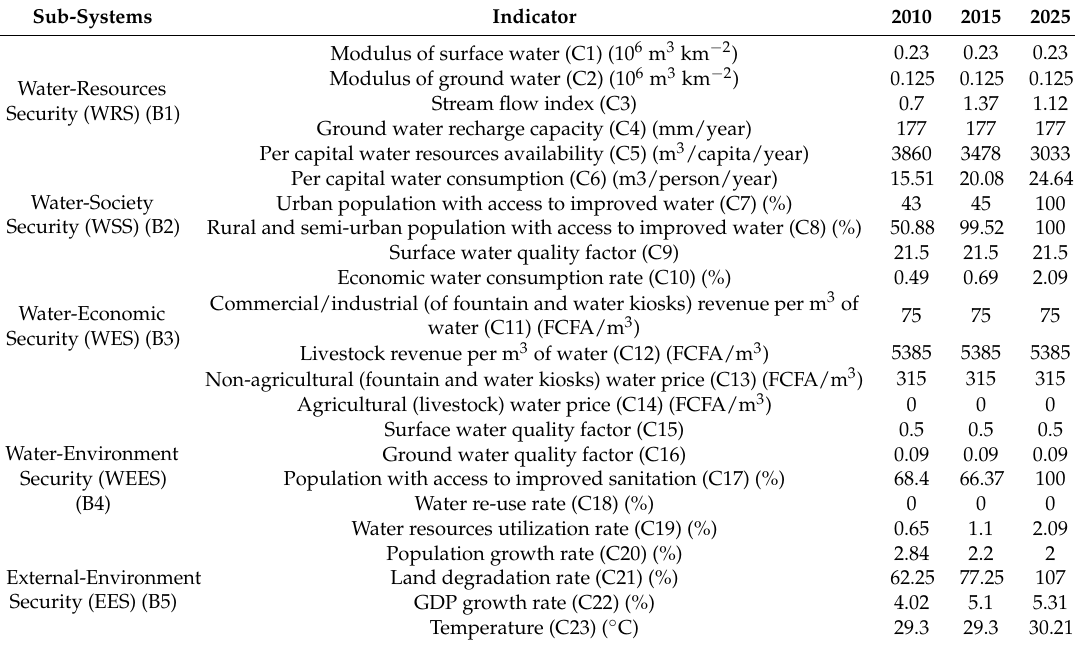
Table 2. Basin level water security indicator values (observed and